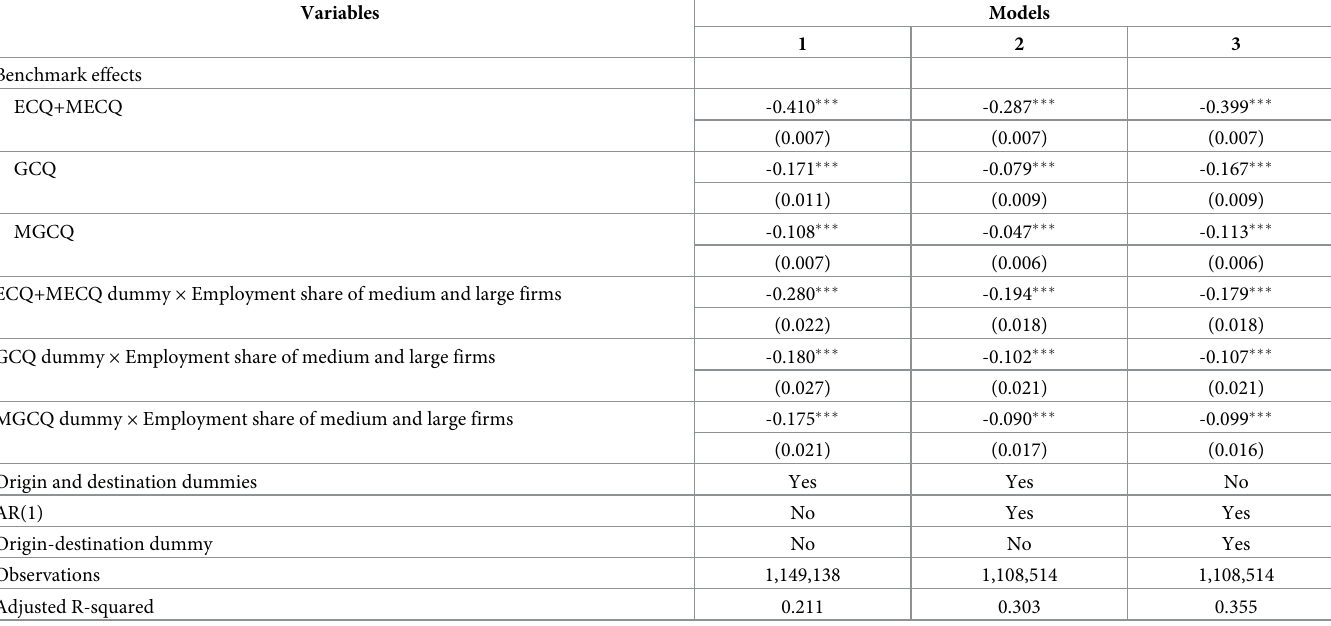
Table 4B. Effects of lockdown measures by destination city firm size composition (balanced panel of city